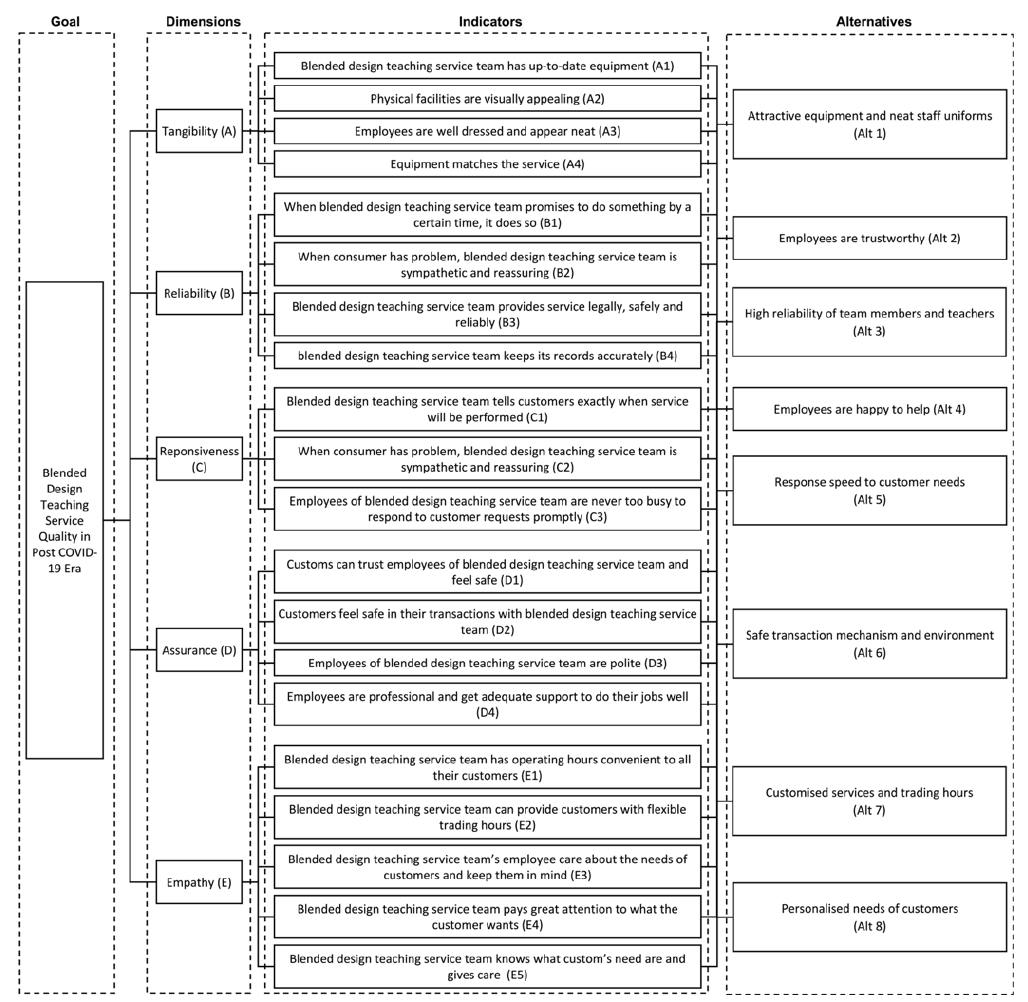
Table 3. The information about 10 experts.